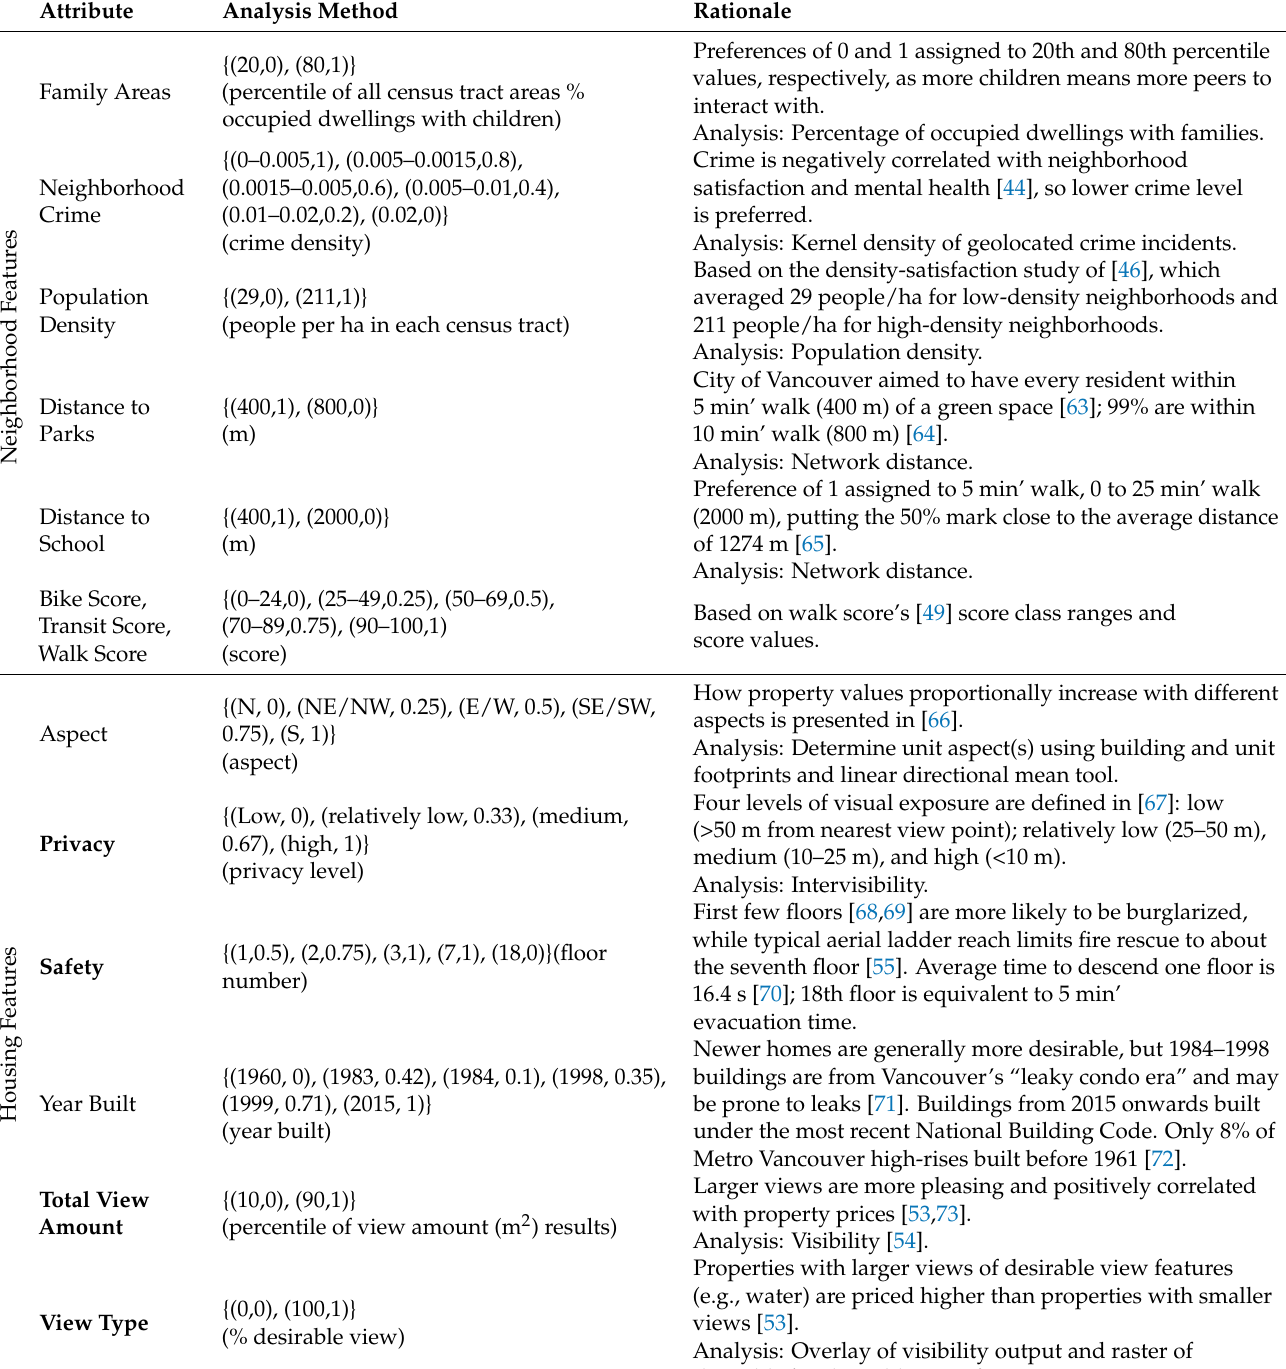
Table 1. Elementary attribute criteria in vertex notation format with associated criterion function breakpoints and rationale. Attributes that are 3D in nature are highlighted in bold